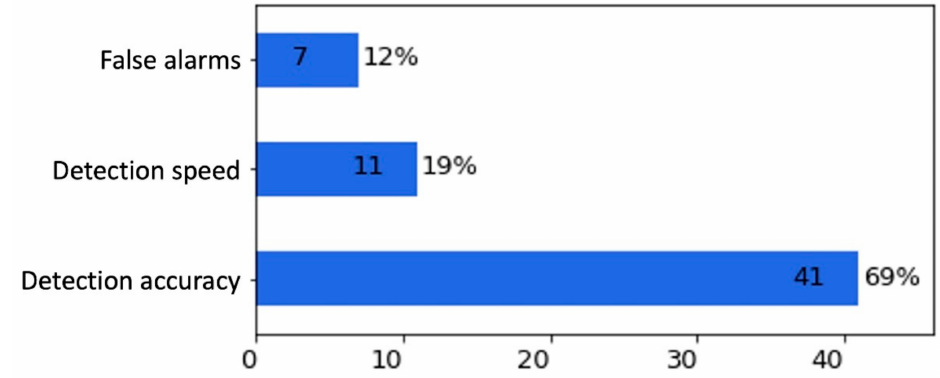
Figure 17. Breakdown of evaluation